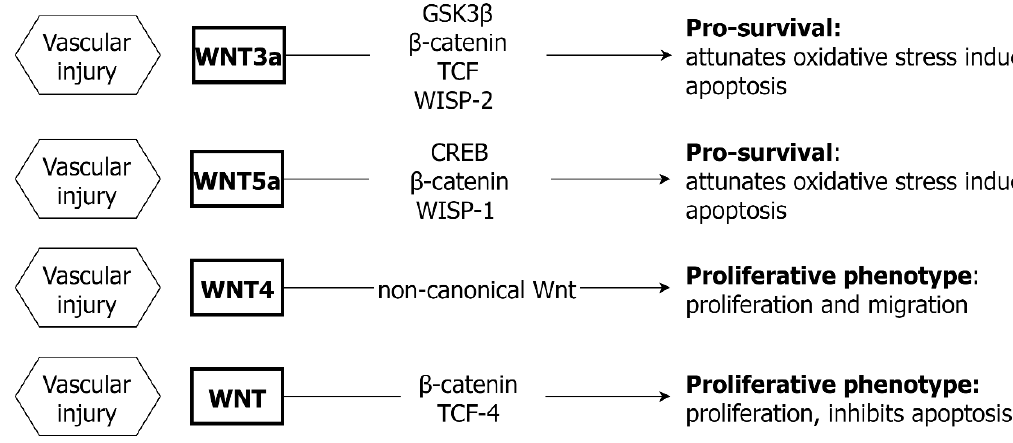
Figure 3. Summary of the mechanisms of WNT signaling pathways in VSMC. Overall, WNT signaling promotes VSMC survival, with non-canonical and β -catenin/TCF4 signaling also promoting VSMC proliferation. VSMC